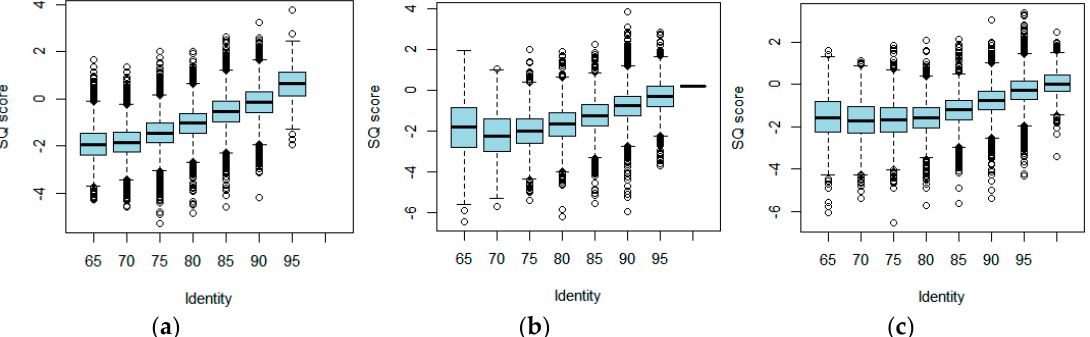
Figure 3 . Relationship of identity and predicted (SQ) score. The identity was grouped into 65–70%, 70–75%, 75–80%, 80–85%, 85–90%, 90–95%, and 95–100%. For each group, the distribution of SQ scores was plotted. ( a ) Comparison of Escherichia coli ; ( b ) comparison of Yersinia pestis ; ( c ) comparison of Drosophila biarmipes